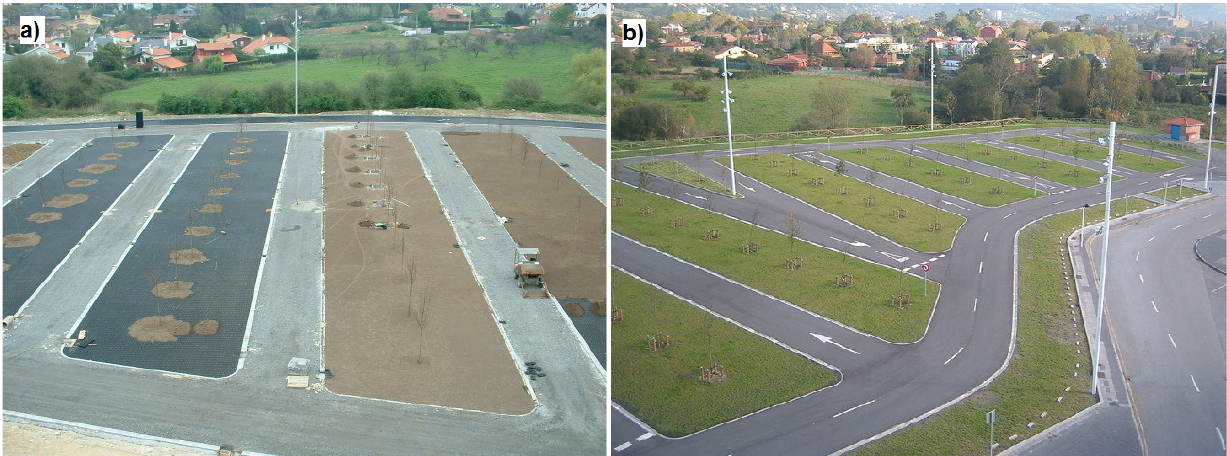
Figure 16. La Guia car park [71]. (a) Construction Phase; (b) Final